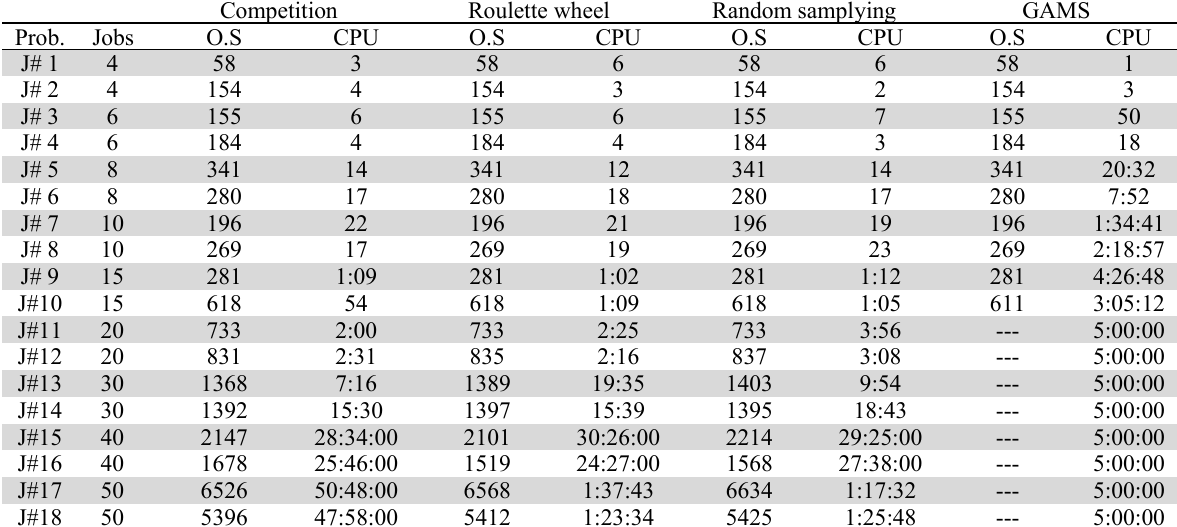
The results of the implementation of GAMS and